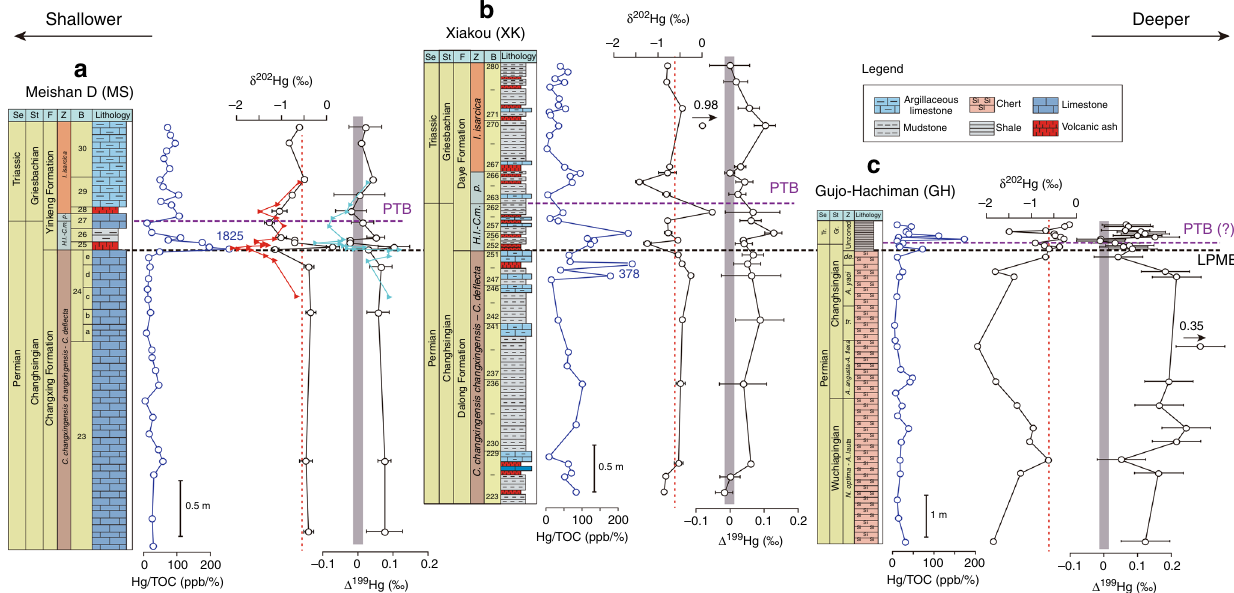
Fig. 3 Mercury isotopes of selected study sections. Pro fi les ratios of mercury to total organic carbon (Hg/TOC), mass-dependent fractionation ( δ 202 Hg), and mass-independent fractionation ( Δ 199 Hg) for three sections: a Meishan D (triangles represent data from 8 ); b Xiakou; and c Gujo-Hachiman. The red dashed lines and shaded rectangles are the background values of δ 202 Hg ( ‒ 0.65 ‰ ) and Δ 199 Hg (0 ‰ ), respectively. A . Albaillella ; C. Clarkina ; de . A. degradans ; H.l.-C.m . H. latidentatus-C. meishanensis ; I. Isarcicella; N. Neoalbaillella; p . H. parvus ; tr . A. triangularis . Gr. Griesbachian, Tr. Triassic; Se Series, St (sub)stage, F formation, B bed, Z conodont zone (all sections except Gujo-Hachiman), and radiolarian zone (Gujo-Hachiman). LPME latest Permian mass extinction, PTB Permian – Triassic boundary. The horizontal bars of the isotope pro fi les indicate standard deviation (2 σ ) values, which are smaller than the symbol size for some samples. Source data are provided as a Source Data fi